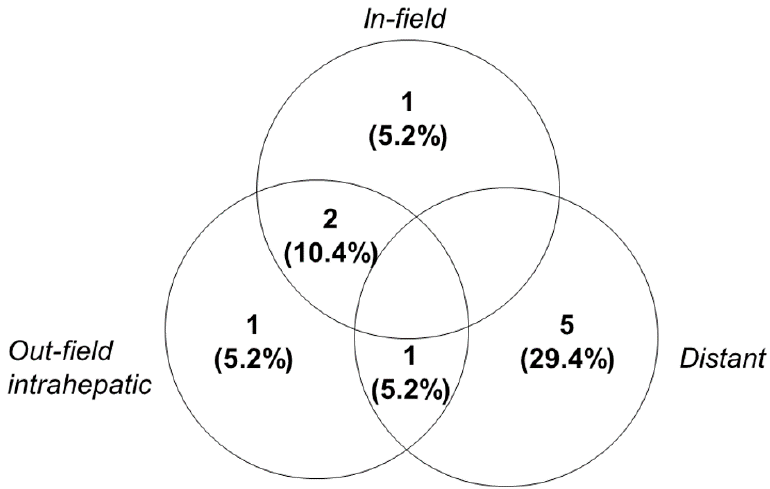
Figure 2. Kaplan–Meir survival curves showing progression-free survival (PFS, dashed line) and overall survival (OS, solid line) of each dose level.